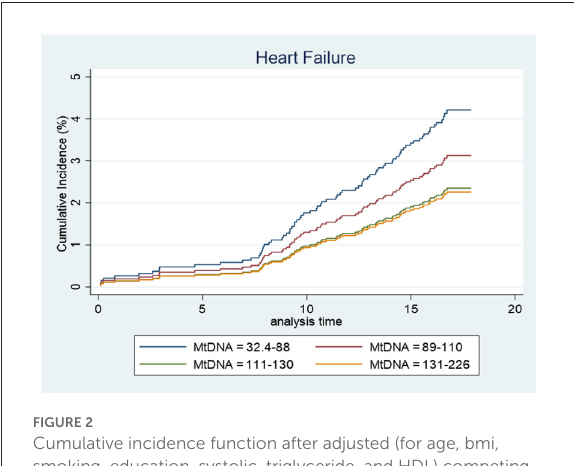
FIGURE2 Cumulative incidence function after adjusted (for age, bmi, smoking, education, systolic, triglyceride, and HDL) competing risk regression where cancer, MI, and death are considered competing events.